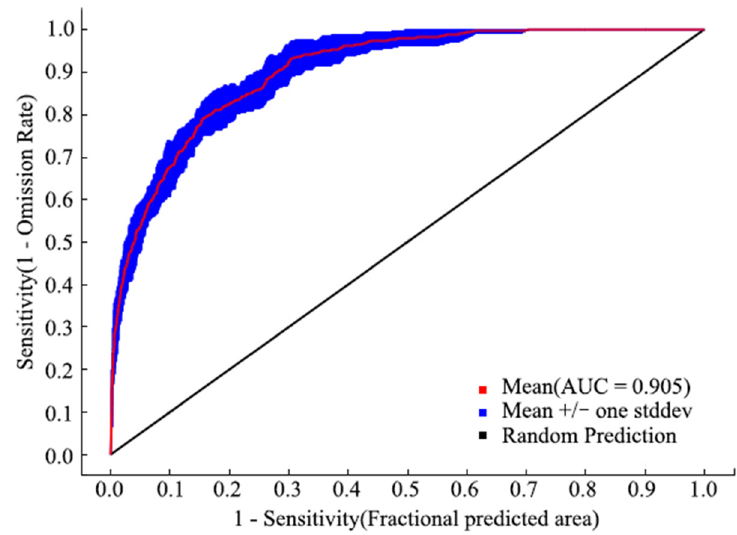
Figure 3. ROC curves and AUC values of the MaxEnt model.